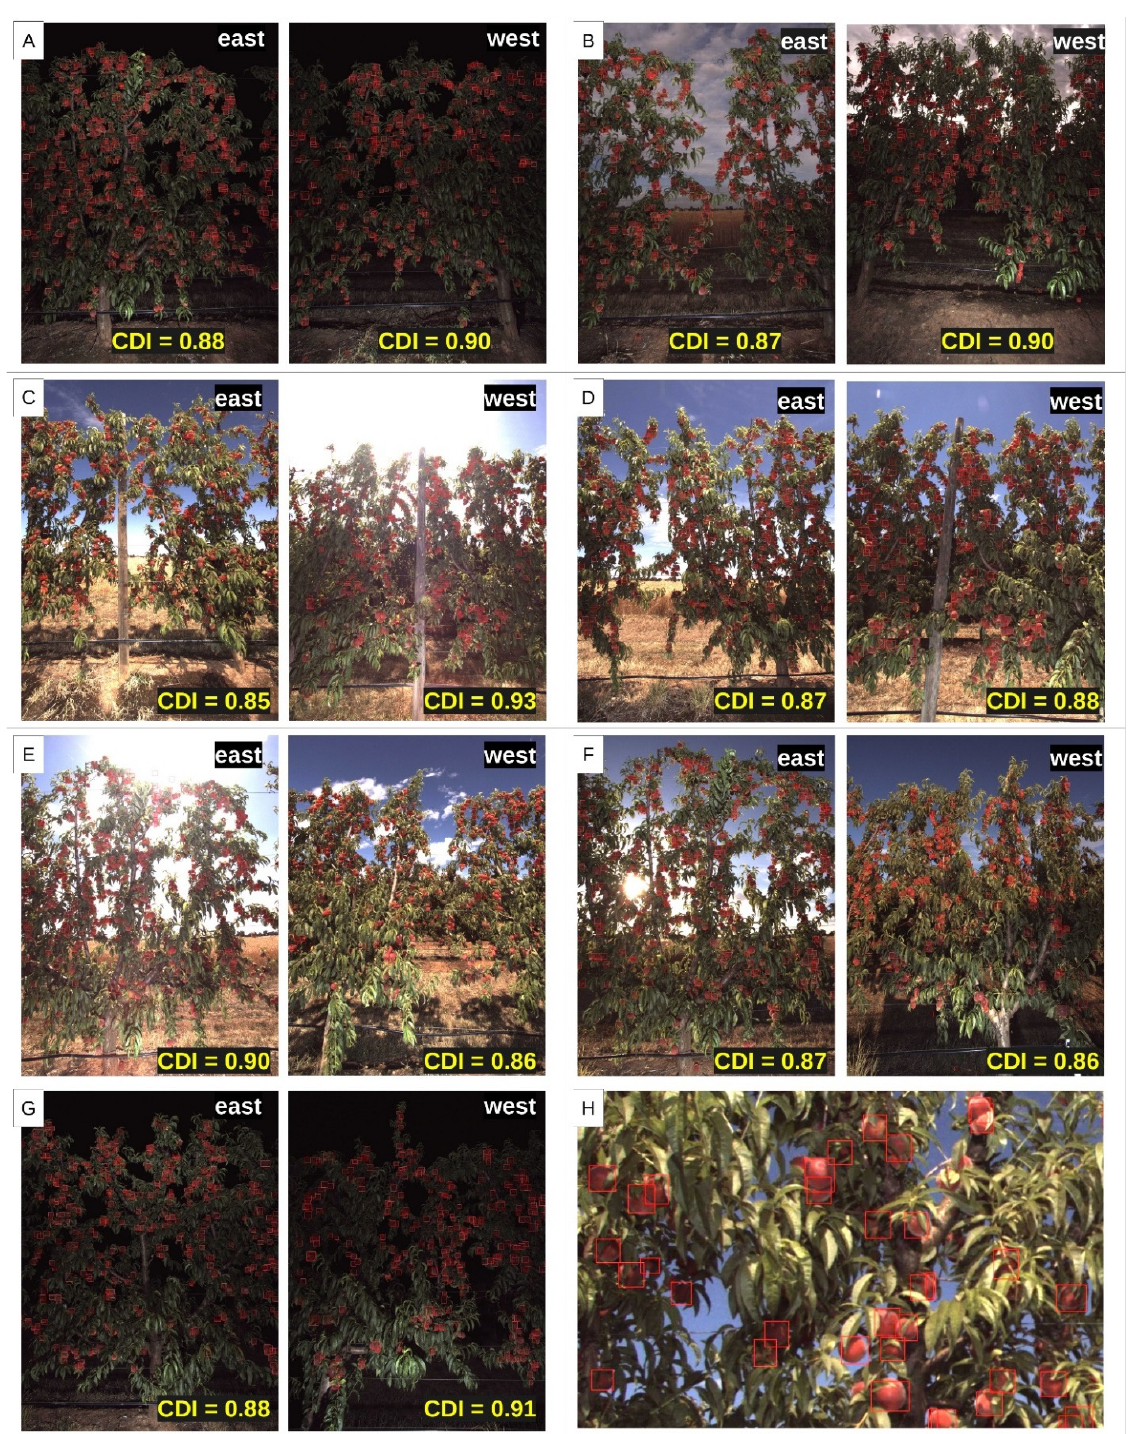
Figure 5. Average fruit Colour Development Index (CDI) per image in ready ‐ to ‐ harvest ‘Snow Flame 23 ′ peach fruit scanned at ( A ) 430, ( B ) 715, ( C ) 1015, ( D ) 1315, ( E ) 1615, ( F ) 1915 and ( G ) 2130 h (AEDT) on 14 December 2021. Images collected on east and west sides of the canopy. Brightness and contrast of the original images was increased by 50% to improve visualisation. In panel ( H ), detected fruit are shown with red detection boxes in a zoomed in image.